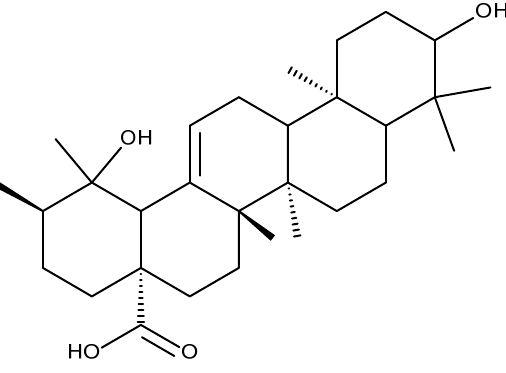
Figure 16. Structure of pomolic acid.